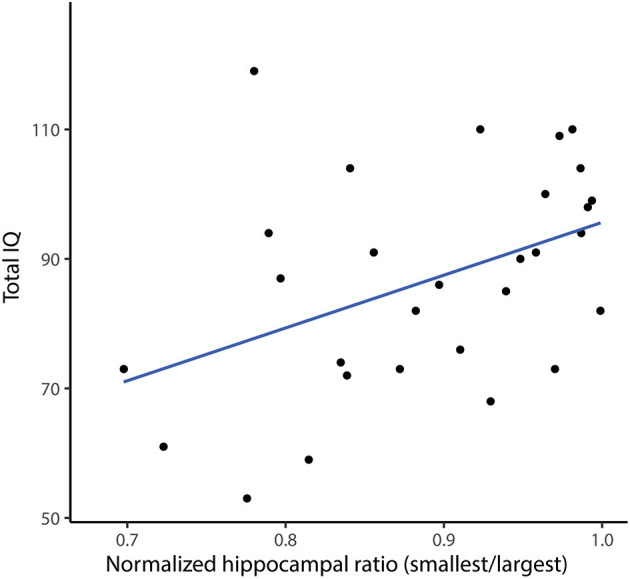
Correlation between pre-resection total IQ and normalized hippocampal ratio (smallest/largest). Each dot represents a patient, the blue line is the fitted linear regression line. There is a positive correlation between pre-resection total IQ and normalized hippocampal ratio, indicating a lower IQ when the left-right hippocampal volume difference is lager (Spearmans r = 0.45, p = 0.015).